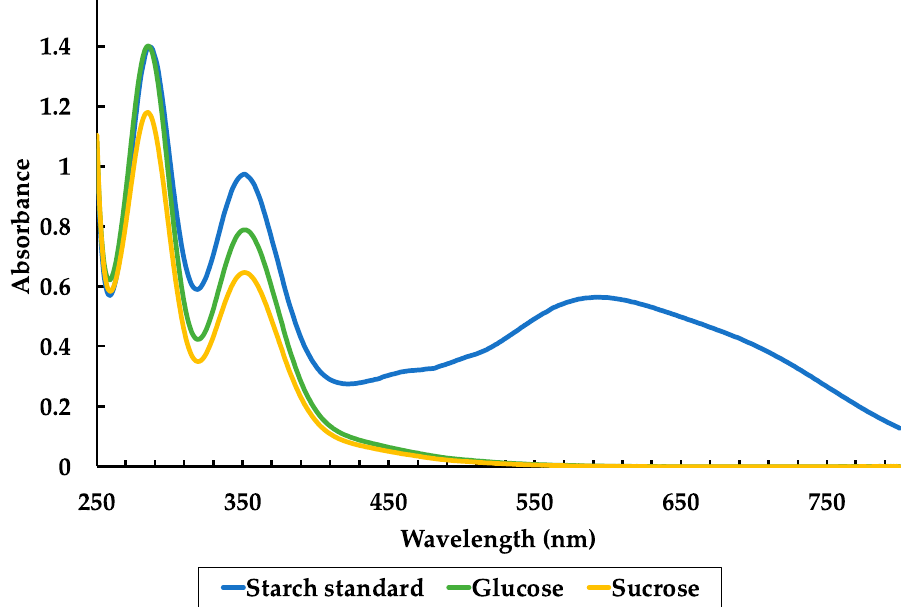
Figure 4. Absorbance spectra of selected saccharides with starch standard for reference using a wavelength range of 250–800 nm. Each sample was run using a concentration of 50 μ g/mL.